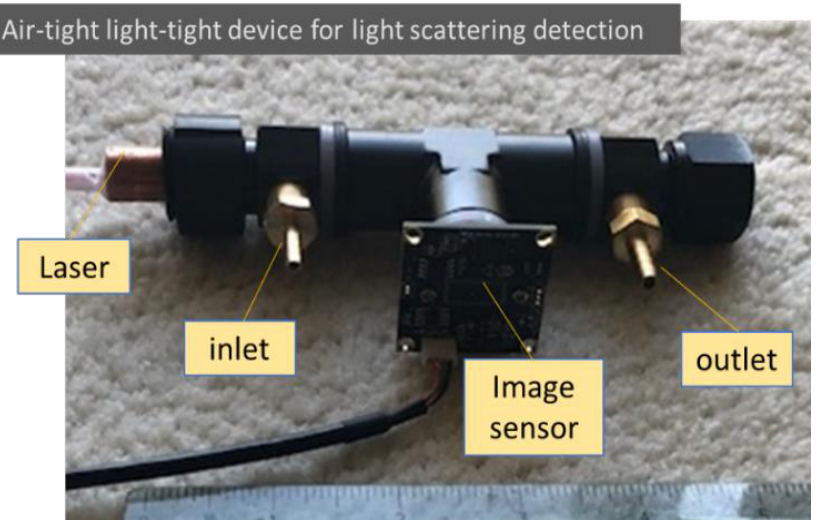
Figure 2. An air-light light-tight device for detecting particle and air molecule light scattering. Low-cost components are used intentionally in the testing setup to check the feasibility for future low- cost applications.